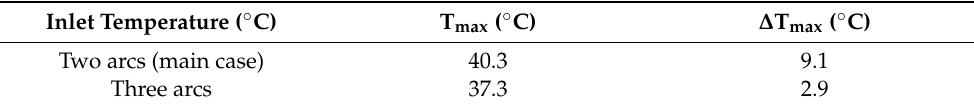
Figure 19. The temperature distribution of the module when using two different tube structures. Table 8. The thermal performance of the system with different arc numbers.